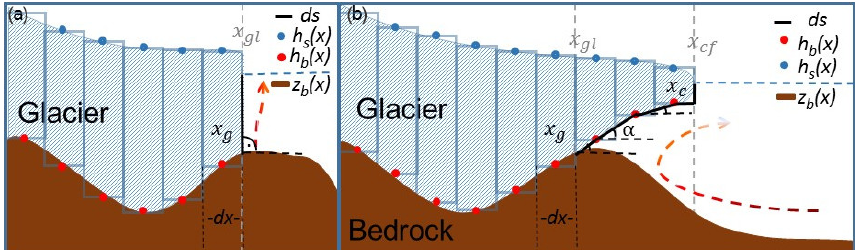
Figure 1. Visualization of the 1-D glacier model with the staggered grid for (a) a tidewater glacier and (b) a glacier with a floating tongue. Red dots indicate where the depth of glacier base h b is defined and blue dots where surface elevation h s of the glacier is defined. They are calculated at d x/ 2 – the half width of each grid cell. Last grounded cell has the coordinate x g and last floating cell has the coordinate x c . The grounding line x gl is determined at the border of the last grounded cell, where the flotation criterion is not yet achieved. After the grounding line, the calculation of submarine melt along the distance d s (thick, black line) is performed with the line plume model. For a floating tongue (b) every grid cell may have a different angle for the slope of glacial base while for a tidewater glacier (a) the angle is set to 90 ◦ . The bedrock elevation z b (brown, thick line) is equal to h b for the grounded part and is deeper for the floating part of the